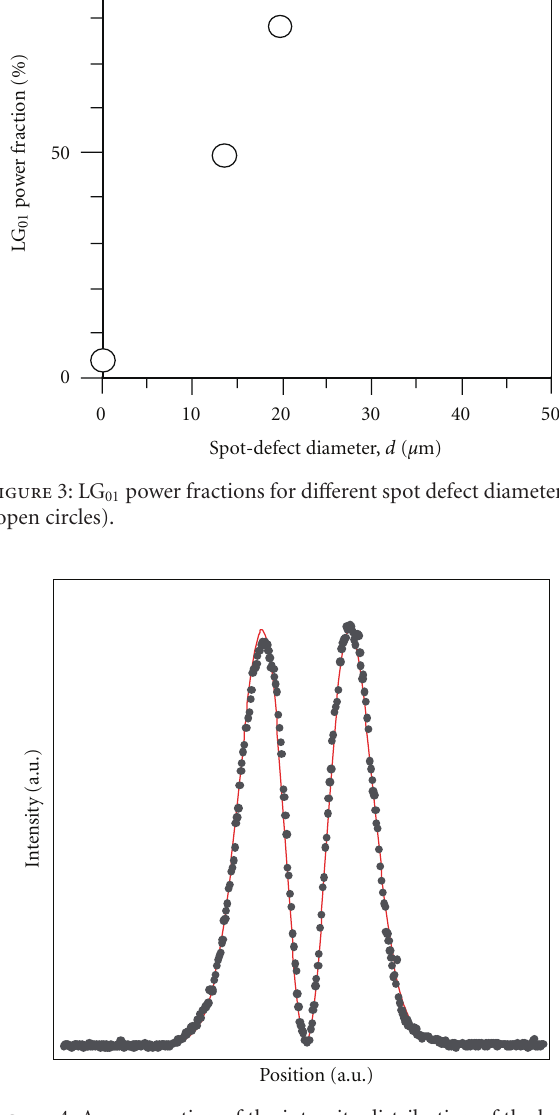
Figure 4: A cross-section of the intensity distribution of the beam for d = 50 μ m. Dotted lines and a red solid curve indicate the measured data and fitting result,